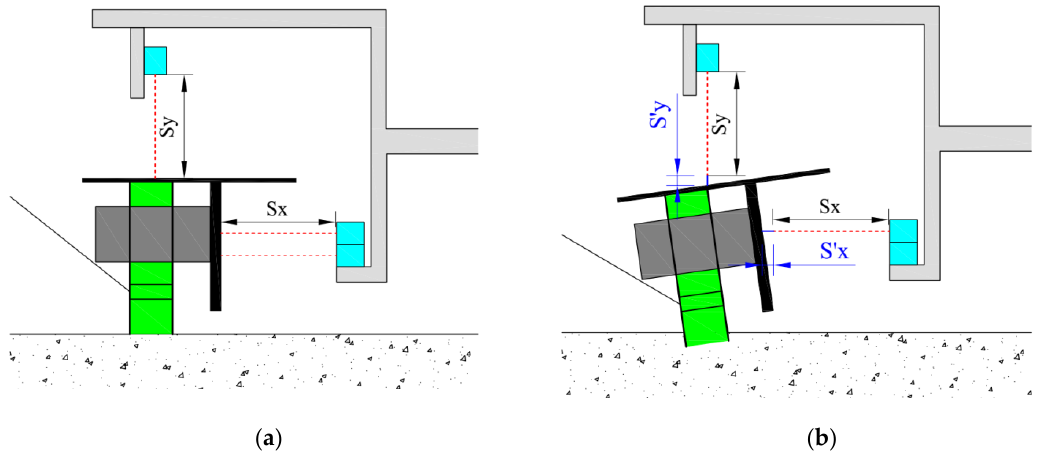
Figure 9. Deformation of anchor piles under oblique loading: ( a ) before deflection, ( b ) after deflection.